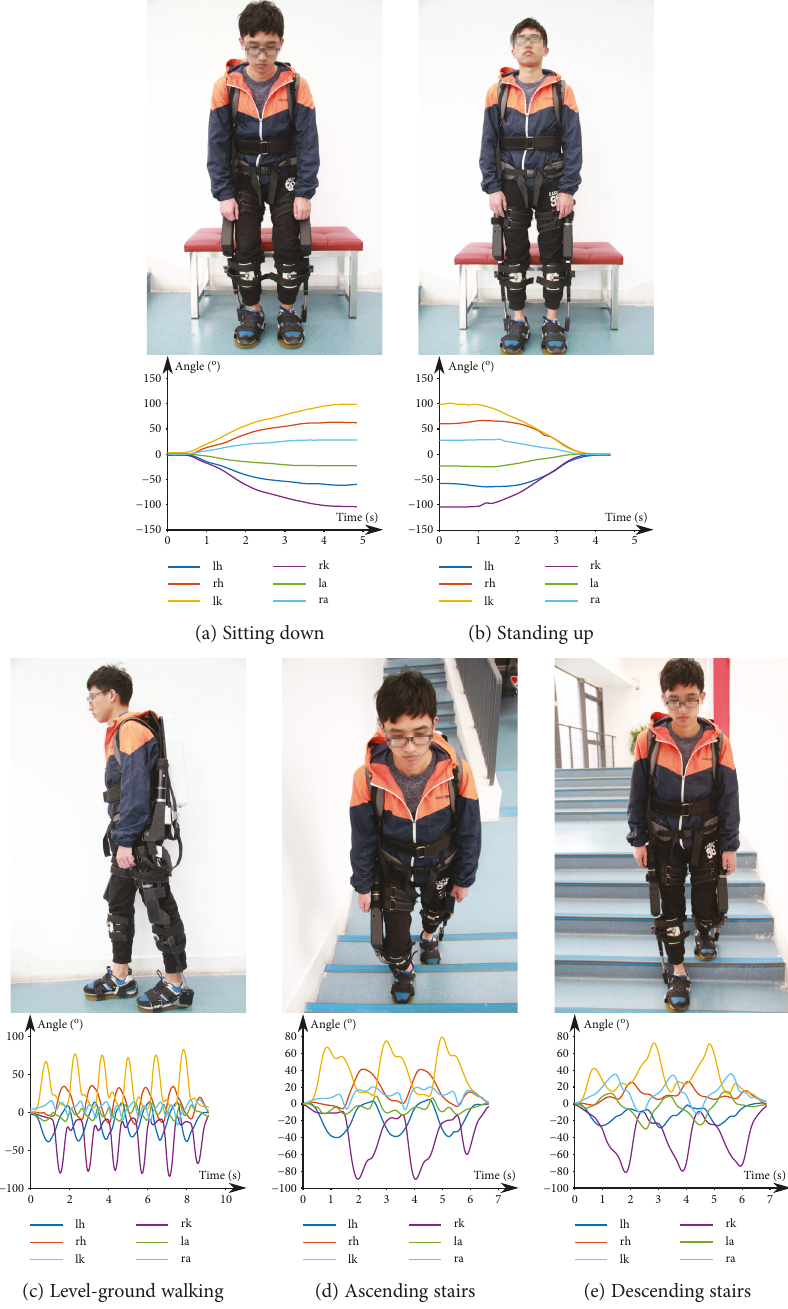
Figure 1: One subject performing di ff erent locomotion modes and corresponding joint position